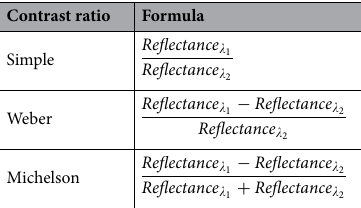
Table 1. Contrast ratios considered in this analysis.